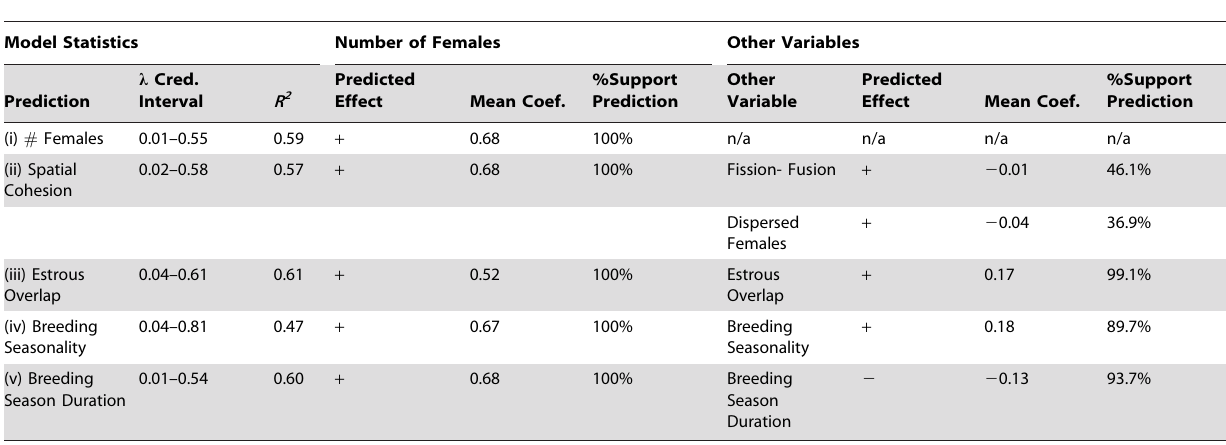
Table 1. Predictors of the number of males in primate groups.